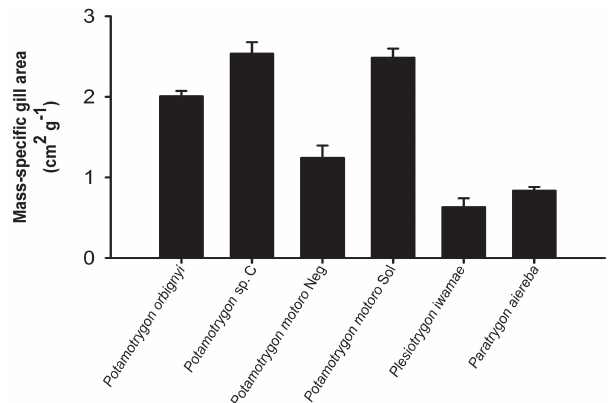
Fig. 4 . Mass-specific surface area of the gills of different potamotrygonid embryos. Two principal component axes (axis 1 – component 1 and axis 2 – component 2) presented eigenvalues greater than 1.0 and were retained for interpretation. These two axes together explained 86.7% of the variability in gill morphometry (component 1, 56.6% and component 2, 30.1%). The relative opening of the spiracle, total gill surface area, and body